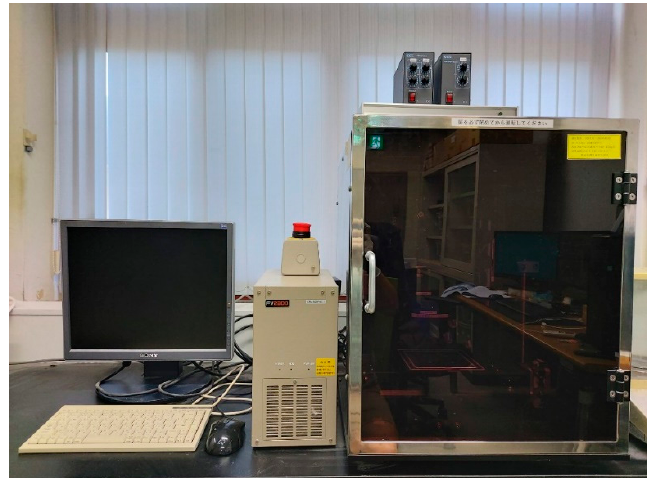
Figure 5. Instrument of image analysis method.